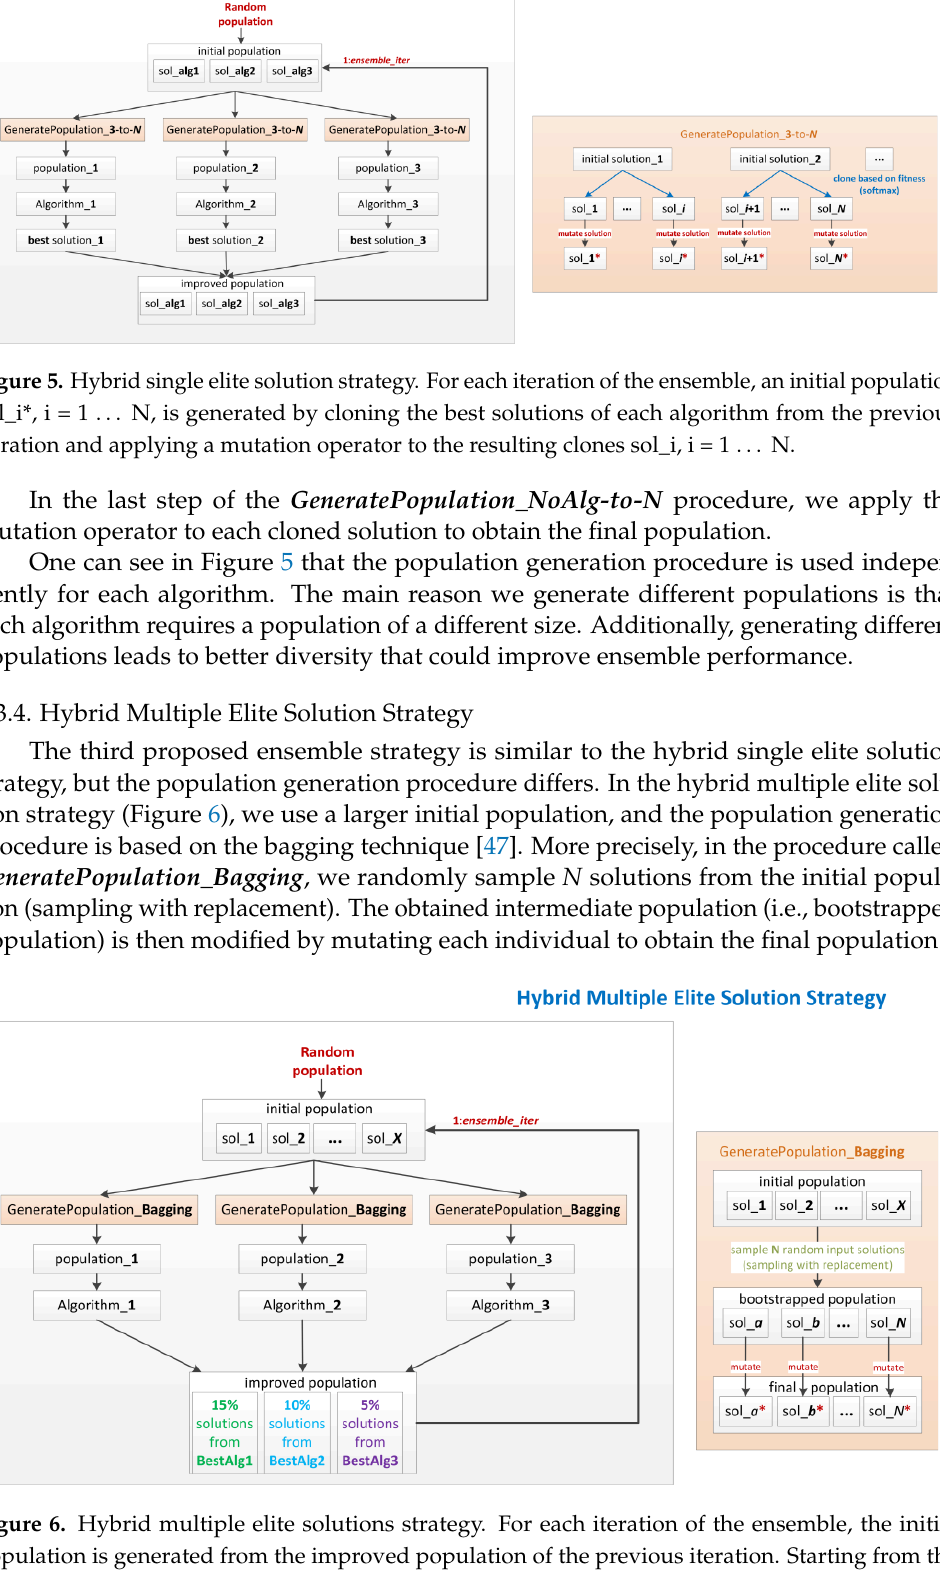
10 of 23 Figure 4. Hybrid cascade strategy. For each iteration of the ensemble, the initial population is gen- erated from the improved solution of the previous iteration. Starting from this solution, a new population sol_i*, i=1..N, is generated by applying a mutation operator to clones sol_i, i=1..N of the previously-improved solution.